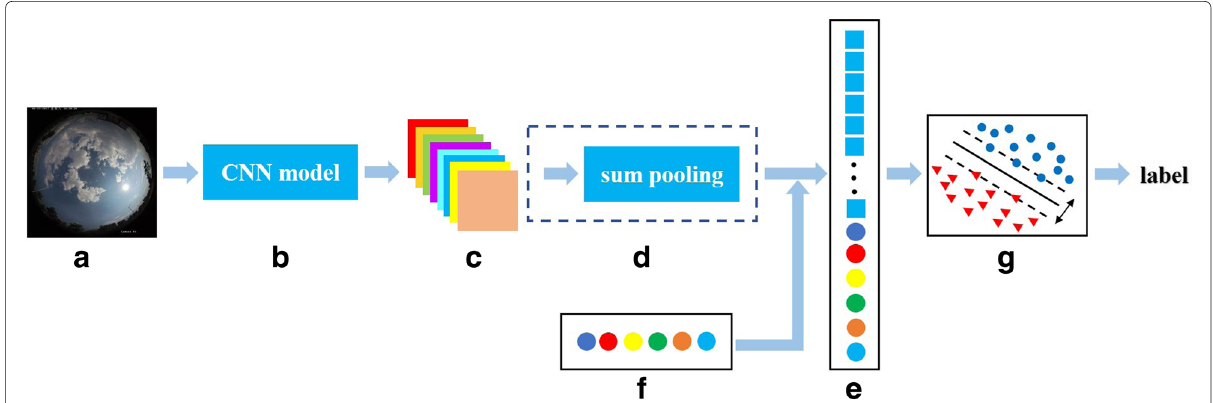
Fig. 1 The flowchart of the proposed method. a Input cloud image. b The CNN model. c Convolutional activation-based features. d Sum pooling strategy for convolutional activation-based features. e Fusing visual features with the multimodal information. f The multimodal information. g The SVM